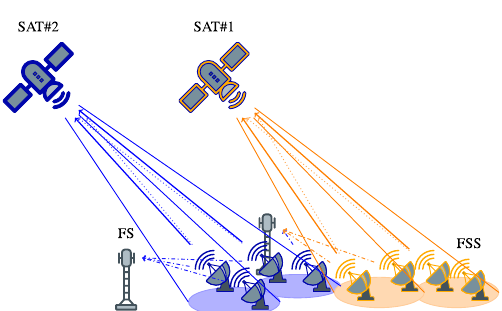
Fig. 1 A multi-operator cognitive UL SatCom system composed of two operators. Each satellite has two beams, represented by ellipses, and two users (FSS) per beams. The dotted lines represent the inter-beam interference and the dashdotted lines represent the interference on primary users (FS) created by secondary users